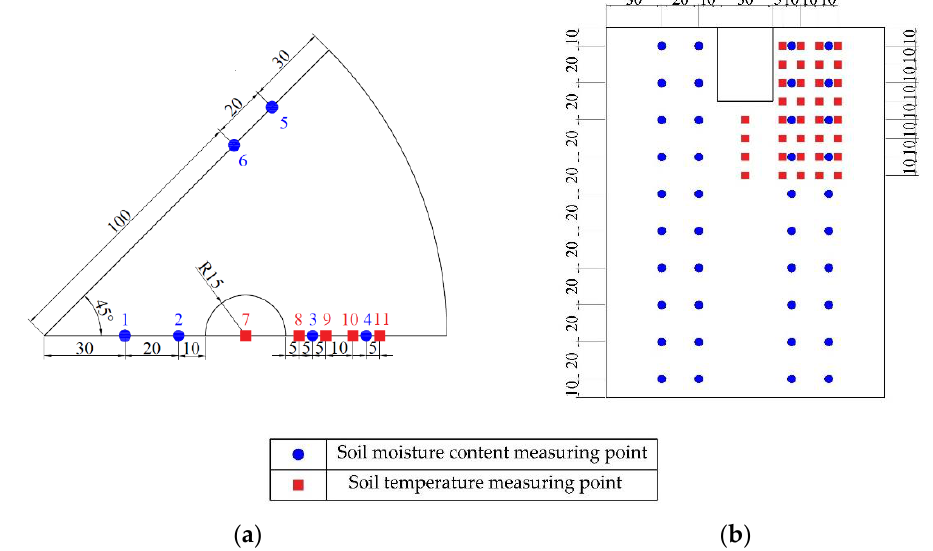
Figure 3. Distribution of soil moisture content and temperature measurement points. ( a ) Horizontal distribution; ( b ) Vertical distribution.